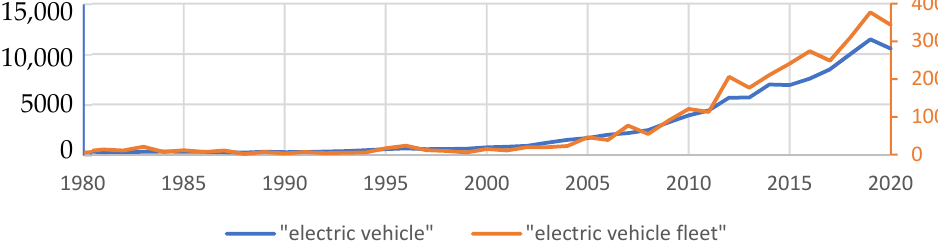
Figure 1. Number of publications found via Scopus ® per year for the search terms shown in the legend. Note that not all of the publications submitted in 2020 will likely have been accepted yet, leading to a slightly lower actual value for 2020 [4].